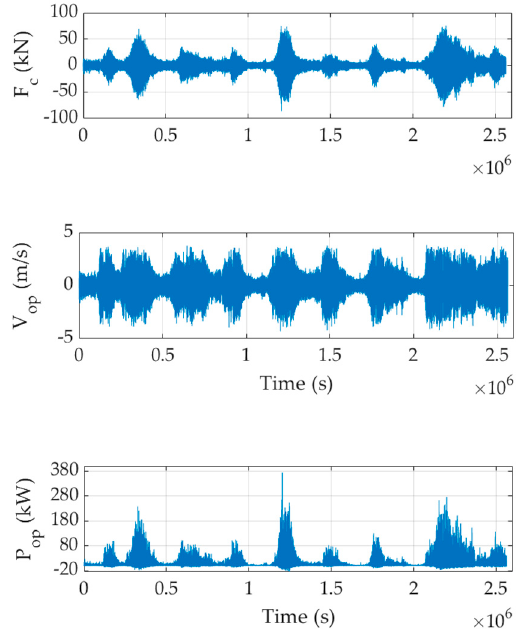
Figure 7. Buoy-required control force and optimal velocity inputs in March.